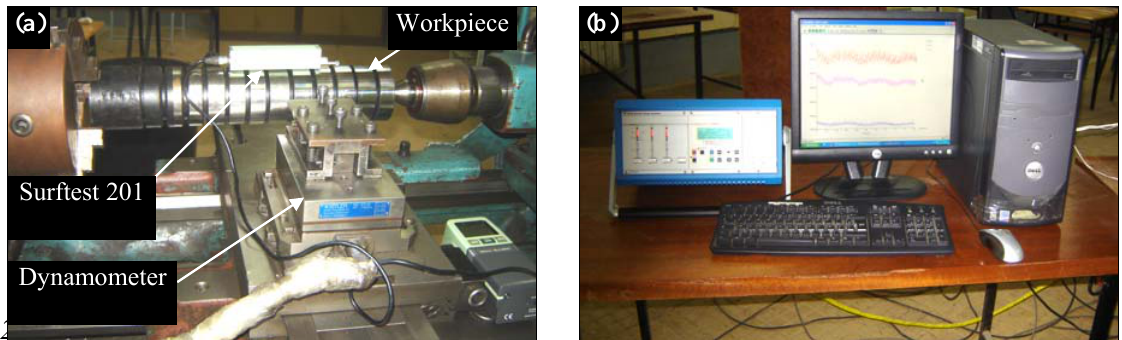
Fig.1. (a) Experimental setup with measurement of the cutting forces by piezoelectric dynamometer and surface roughness, and (b) charge amplifiers and PC based data acquisition